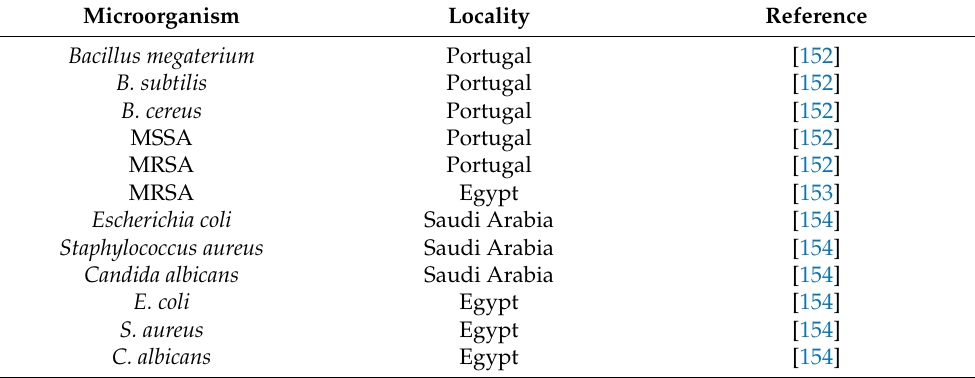
Table 3. Examples of tests with positive results of synergy between extracts of propolis and